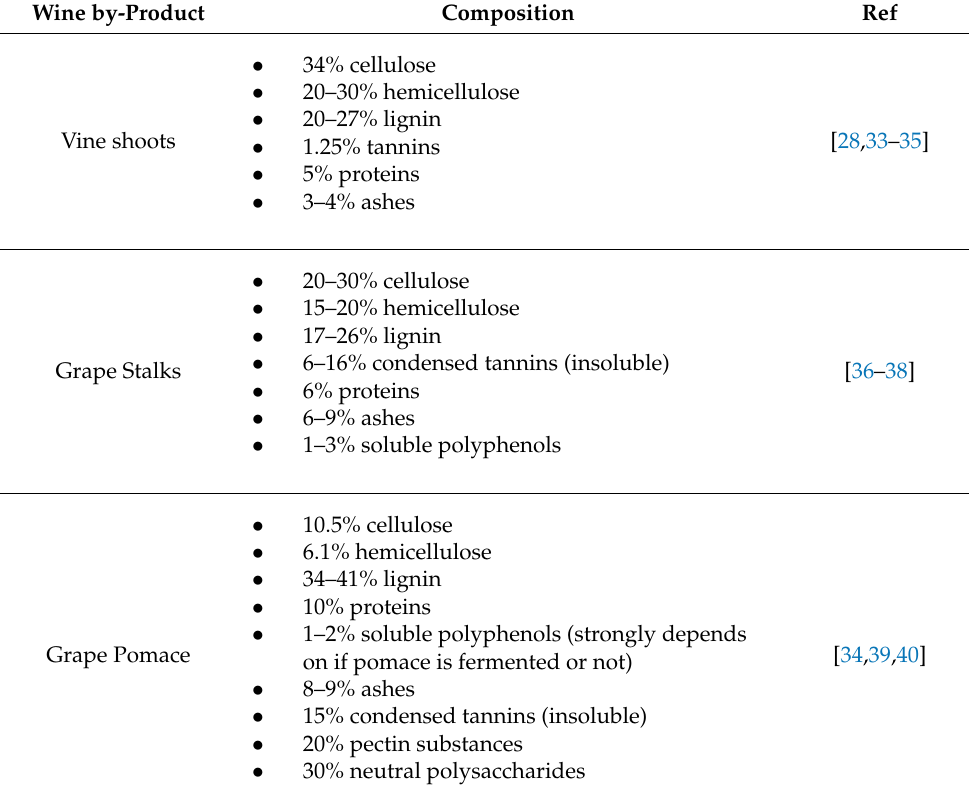
Table 3. Wine by-products